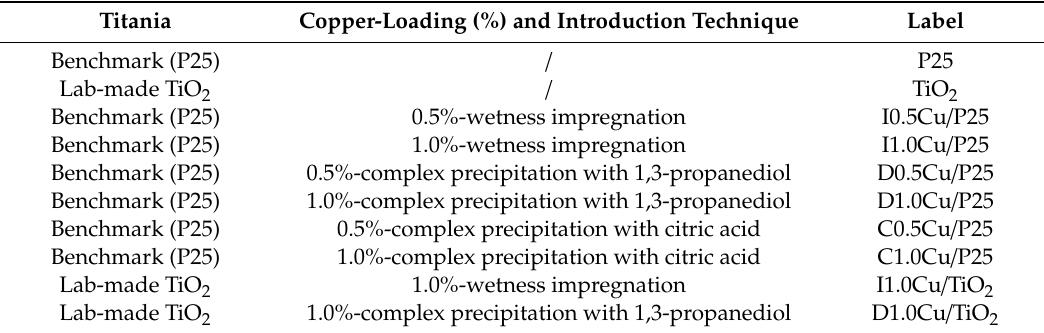
Table 1. Titania and copper-promoted titania